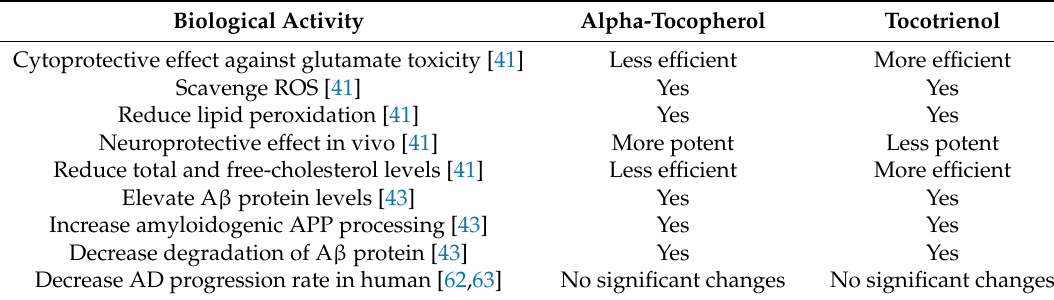
Table 2. A comparison in neuroprotective effects between alpha-tocopherol and